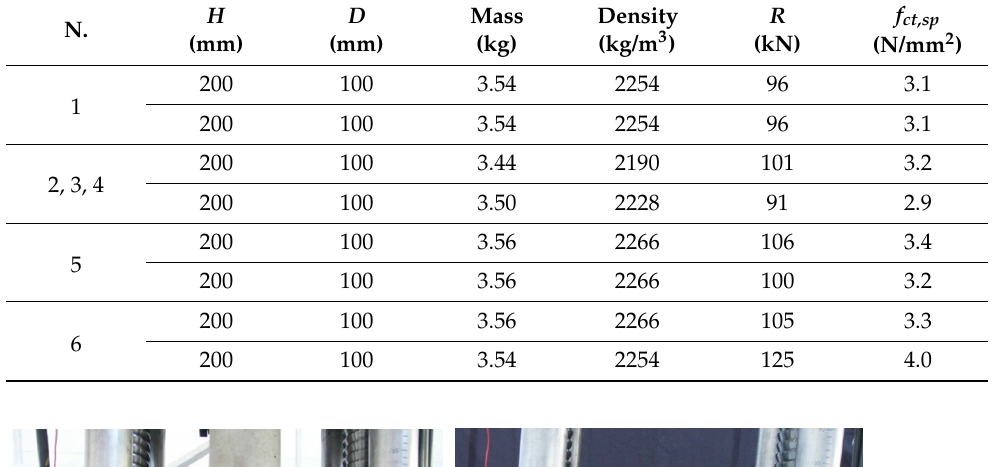
Table 3. Results of indirect tensile tests on concrete specimens.